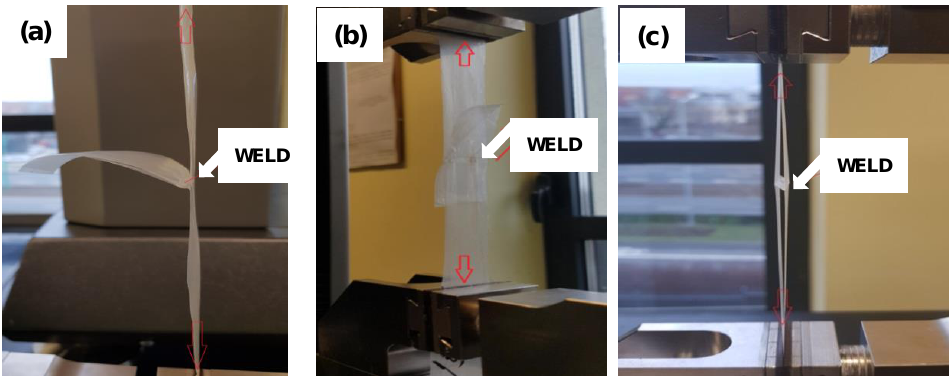
Figure 9. View of the welded specimens mounted in tensile machine grips, in tested mode: ( a ) seal strength, ( b ) lap shear test, and ( c ) tear the weld test.